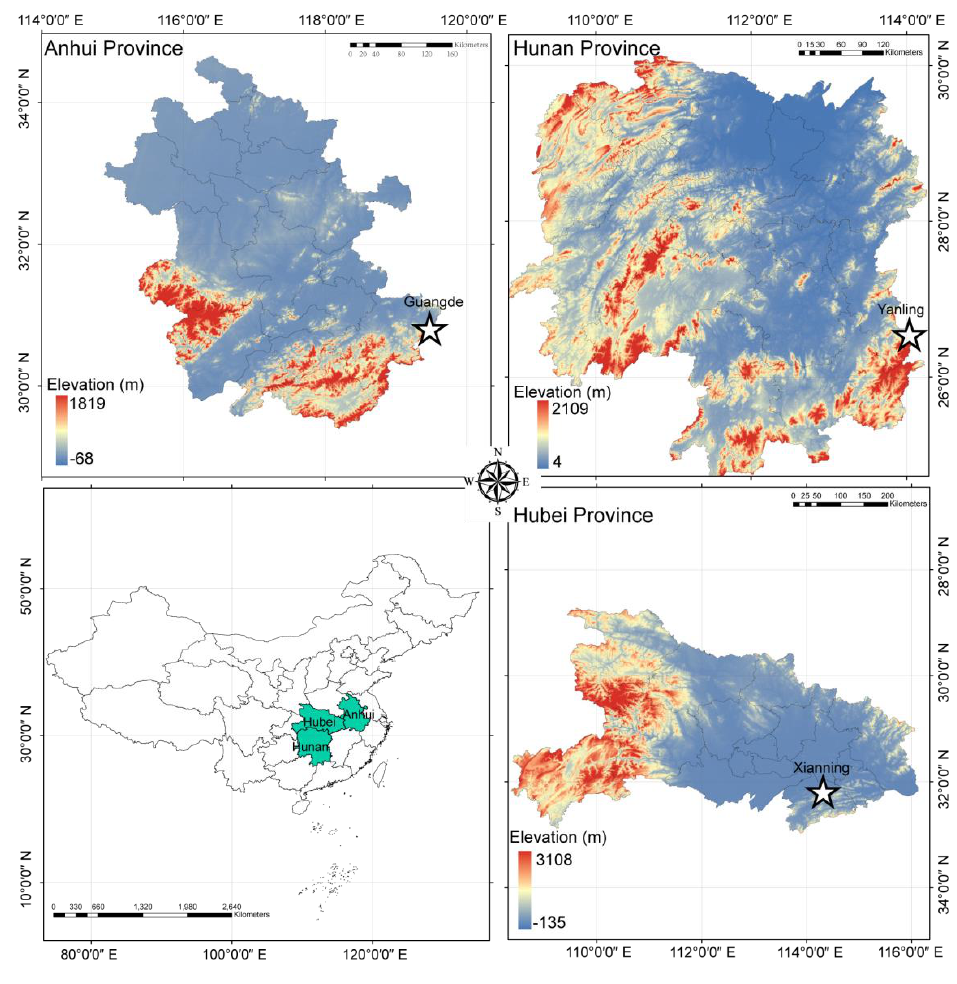
Figure 8. Study area. Table 1. The structure of the Bayesian